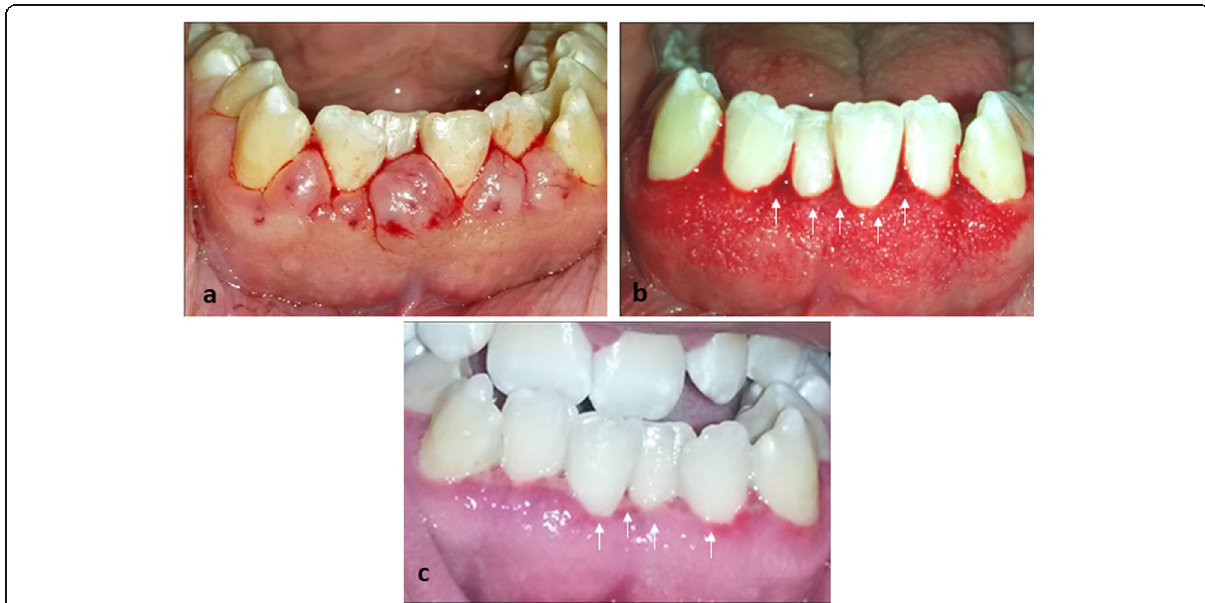
Fig. 2 Clinical view of gingival enlargement in mandibular incisors indicated for gingivectomy (control group). a Before gingivectomy procedure. b Immediately after gingivectomy. c Gingival healing 2 weeks post-surgery. Note the change in gingival contour after surgery (white arrows in b ) and 2 weeks later (white arrows in c